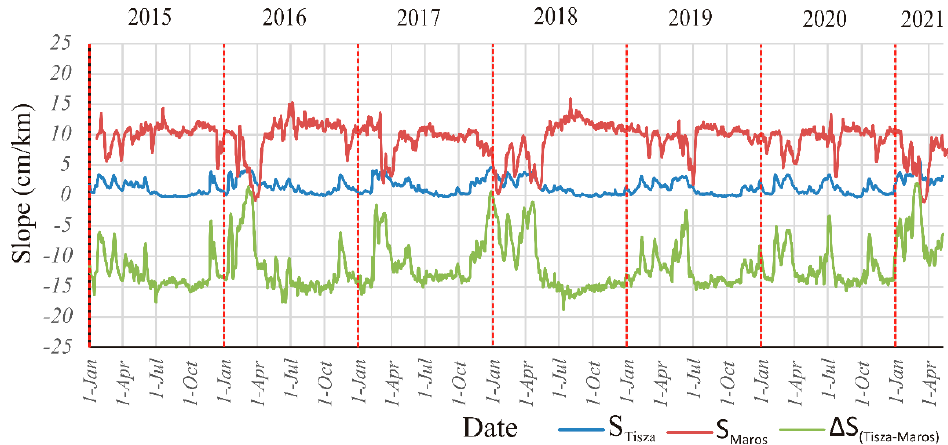
Figure 4. The calculated daily slope of the Tisza and Maros Rivers and their slope difference ( Δ S)